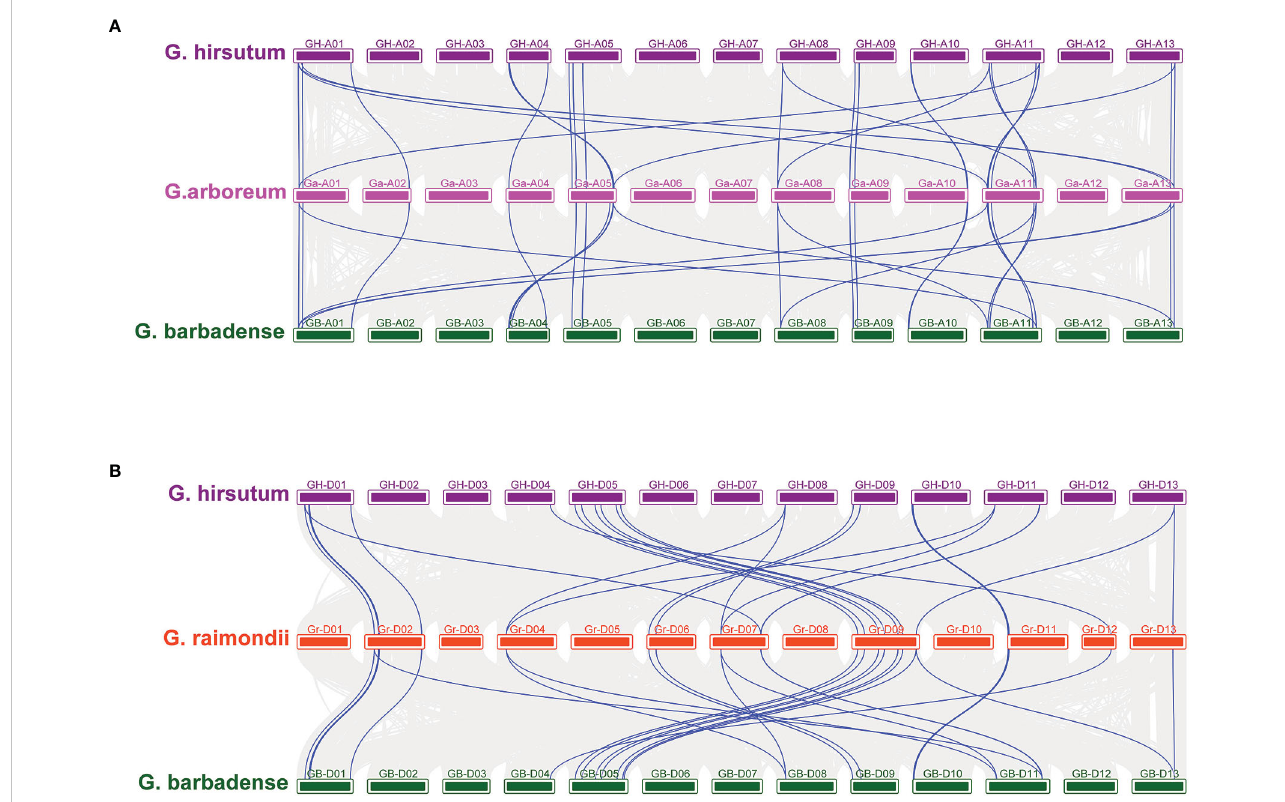
FIGURE 5 Collinearity between allotetraploid and its ancestral species (A) Collinearity of GhTPSs and GbTPSs compared with G arboreum . (B) Collinearity of GhGUT and GbTPSs compared with G raimondii. The blue line represents the TPS gene pair.